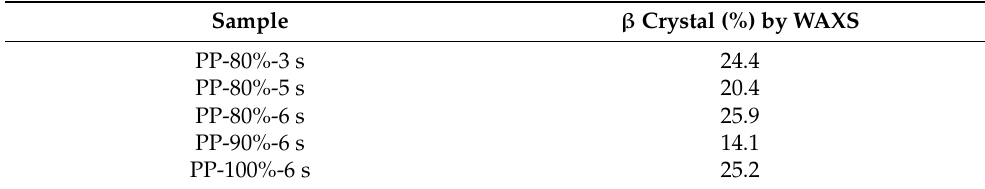
Table 2. Amount of β -crystal quantified by WAXS for specimens injected by the UMIM process.